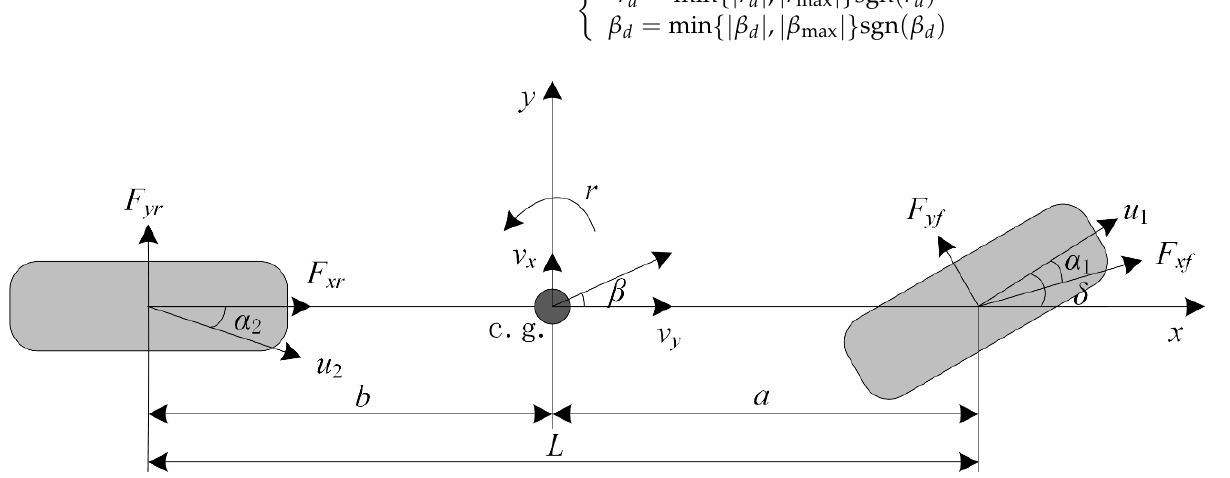
Figure 1. The 2-DOF distributed drive electric bus model. Table 1. The basic parameters of the distributed drive electric bus. Parameters Symbols Values Bus mass m 7620 kg Distance from the center of mass to the front axle a 3105 mm Distance from the center of mass to the rear axle Cornering stiffness of the front